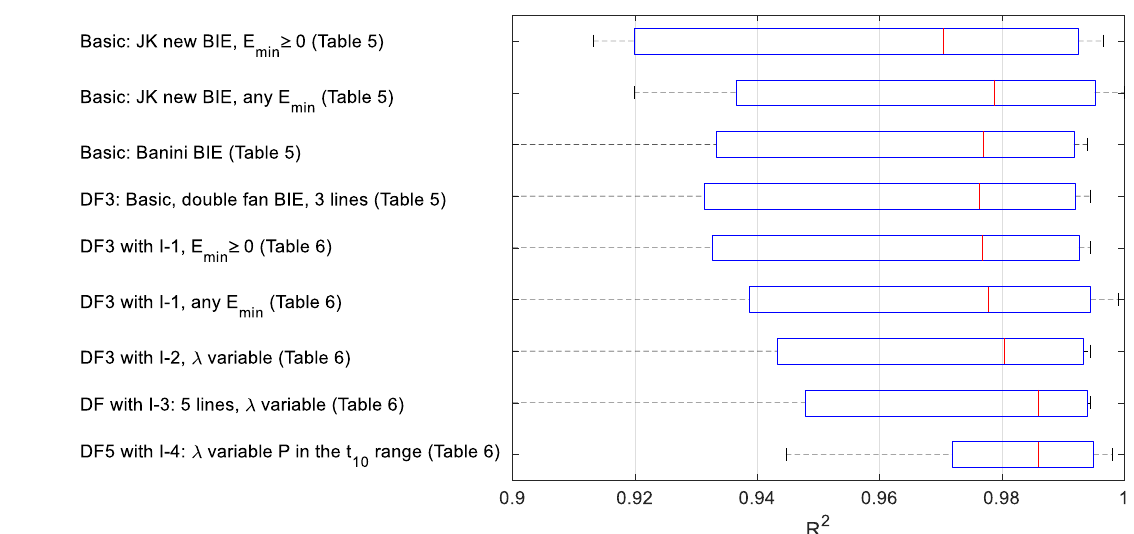
Figure 10. Bar chart on the fidelities of the different BIEs for the available data in Tables 5 and 6.